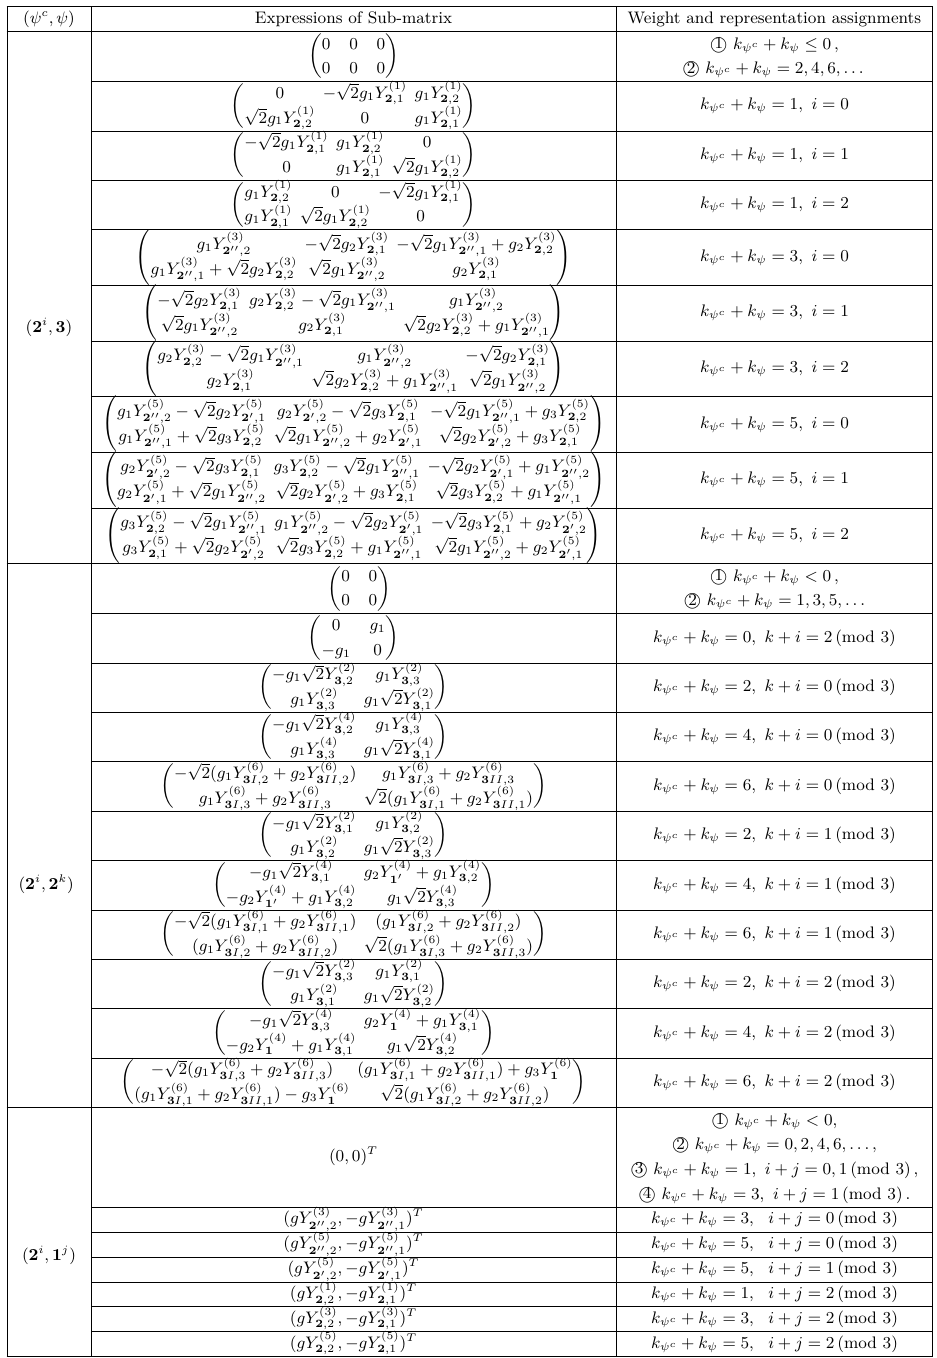
Table 2. Possible submatrix forms for the charged-lepton mass matrix up to weight-6 modular forms, for the case where the RH charged lepton field ψ c transform as 2 i and the LH lepton doublet ψ as 3 , 2 k or 1 j under T 0 modular symmetry. Their modular weights are denoted by k ψ c and k ψ , respectively. The parameters g are coupling constants. If the representation assignments of ψ and i ψ c are exchanged, the corresponding submatrix is the transpose of the original